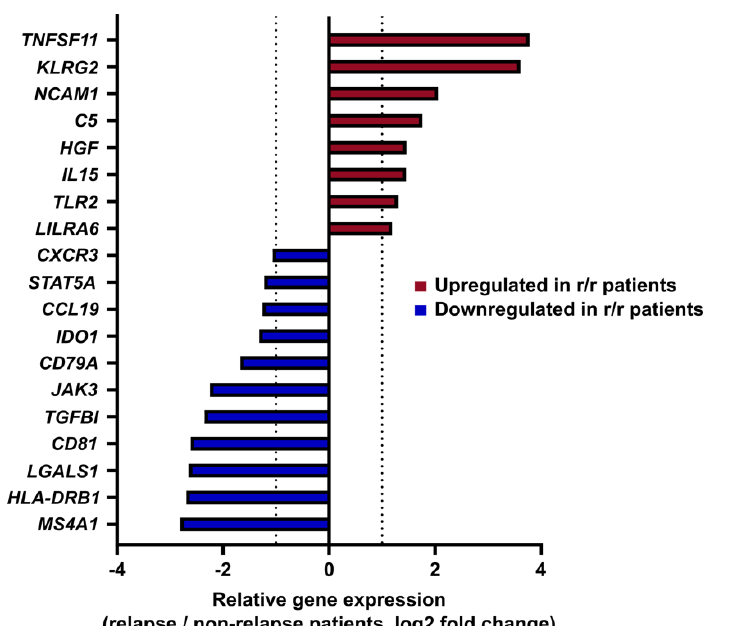
Figure 1. Prognostic immune gene signature in classical Hodgkin lymphoma: Differentially expressed genes ( p -value < 0.05 and |fold change| > 2) in relapse patients compared to non-relapse patients at diagnosis, regardless of the histological subtype.